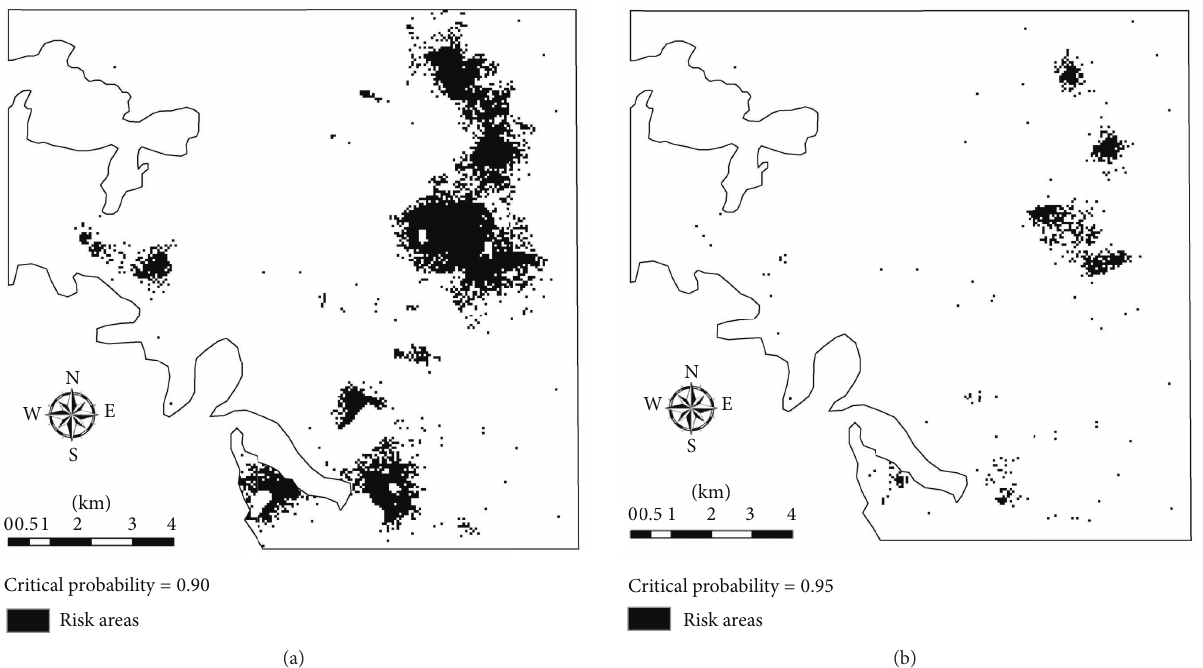
Figure 6: Risk areas based on the probability map of Cd exceeding the composite soil environmental quality standard II of China for Cd in soil given the critical probability values 0.90 (a) and 0.95